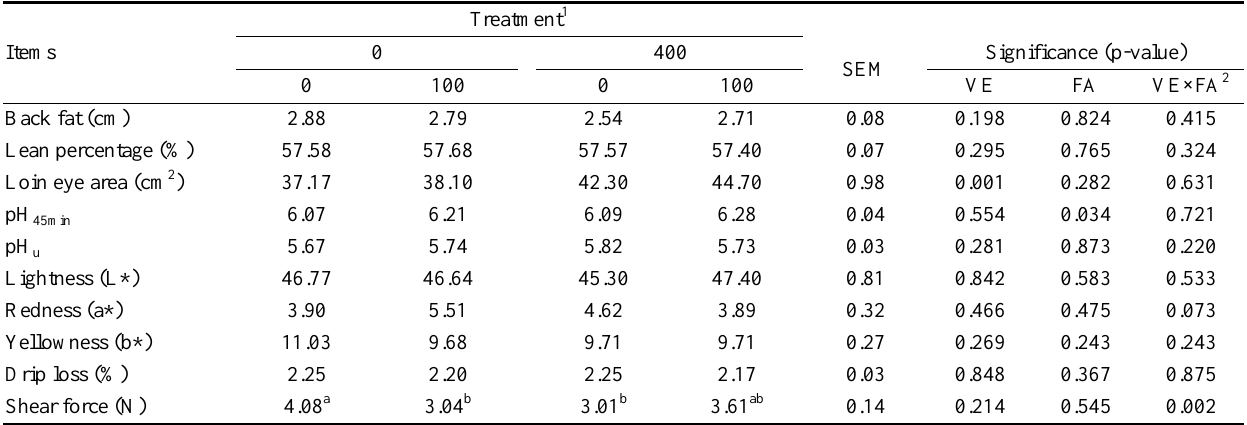
Table 3. Effect of dietary supplementation with vitamin E (VE) and ferulic acid (FA) on carcass traits and meat quality of finishing pigs (n = 6)